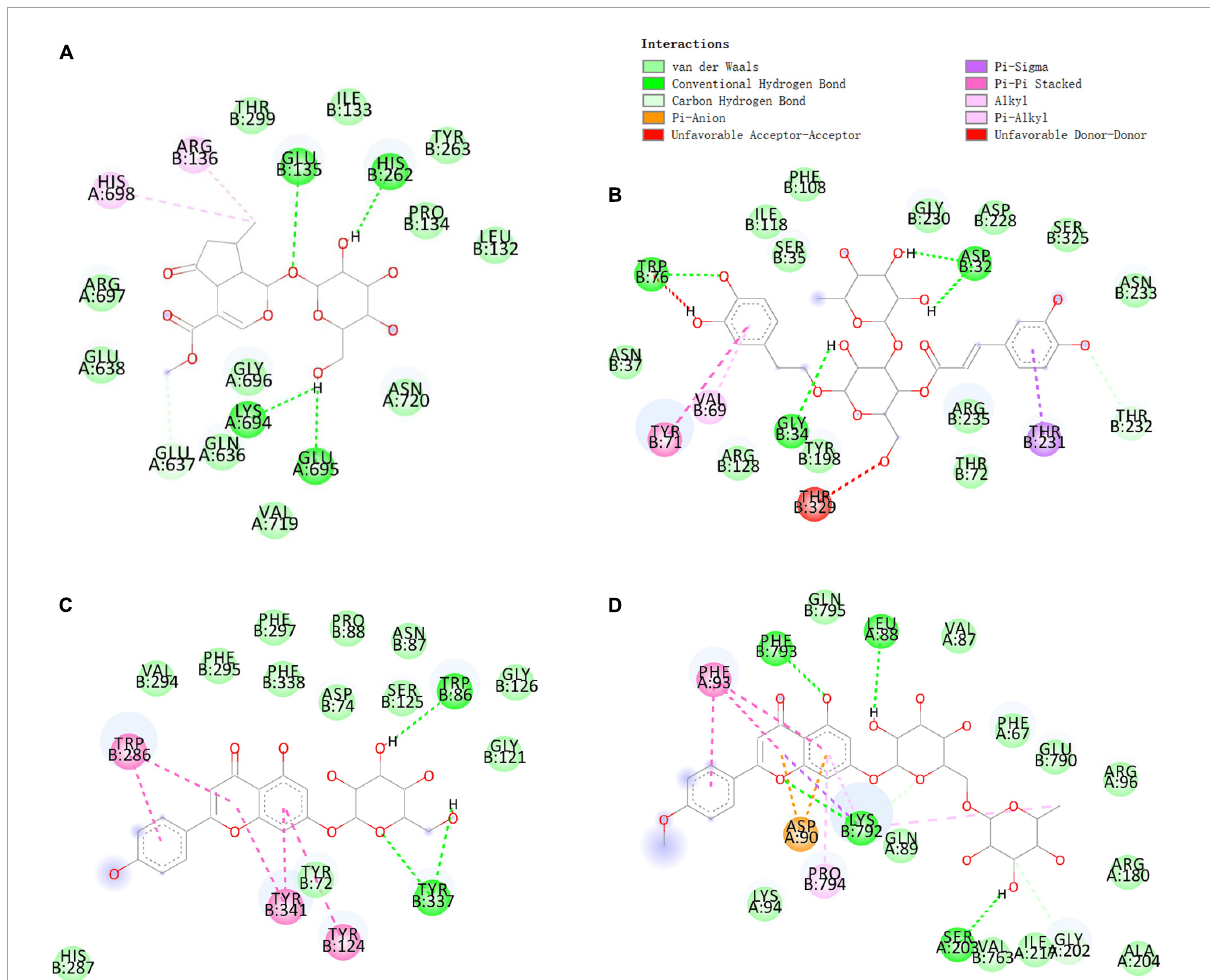
FIGURE2 Molecular docking of some compounds in Verbena officinalis . with AD targets. (A) verbenalin docking with NLRP3. (B) Acetoside docking with BACE1. (C) Apigenin-7- O -glucoside with AChE. (D) Acacetin-7- O -rutinoside docking with GSK-3 β . The figure on the upper left explains that different colors represent different types of compounds that bind with amino